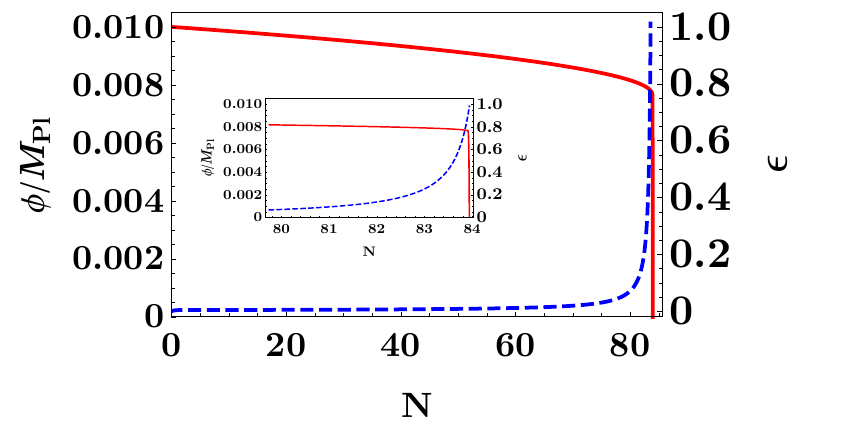
Figure 4 . Scalar field inflationary evolution with initial value ˜ φ = 0 . 01 M Pl and mass m = 500 Λ ? , producing N = 84 e-folds of inflation. Inset: Zooming in over the end of